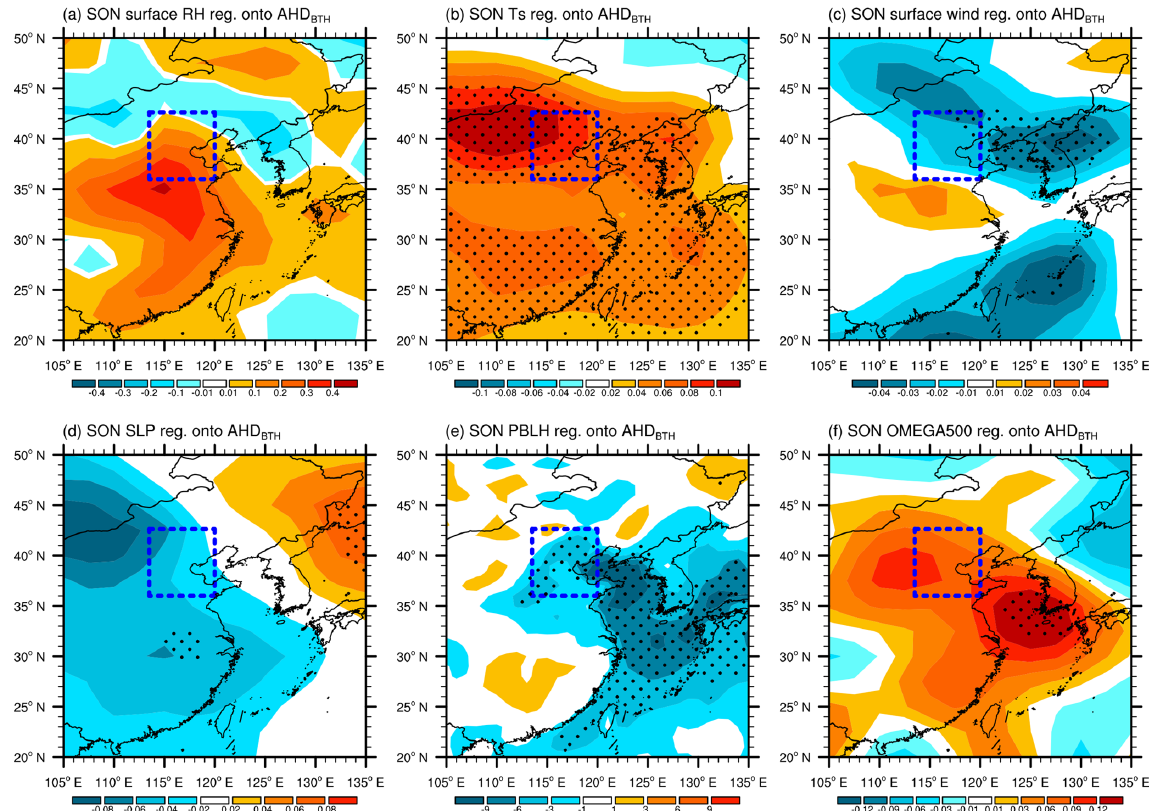
Figure 4. Regressed patterns of autumnal meteorological parameters onto the interannual component of the AHD BTH , including (a) surface relative humidity (shaded; %C), (b) surface air temperature (shaded; ◦ C), (c) surface wind speed (shaded; ms − 1 ), (d) SLP (shaded; hPa), (e) PBLH (shaded; m), and (f) 500hPa omega (shaded; 10 − 2 Pas − 1 ). Regression coefficients that are significant at the 90% confidence level are stippled. The blue dashed box outlines the research domain of the BTH